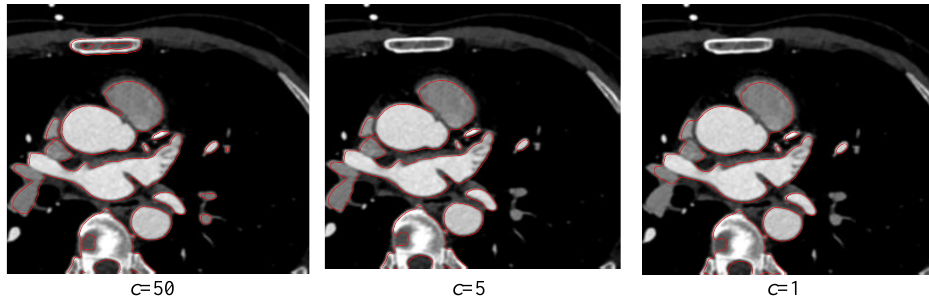
Fig. 2. CAD segmentation with c=50, 5,